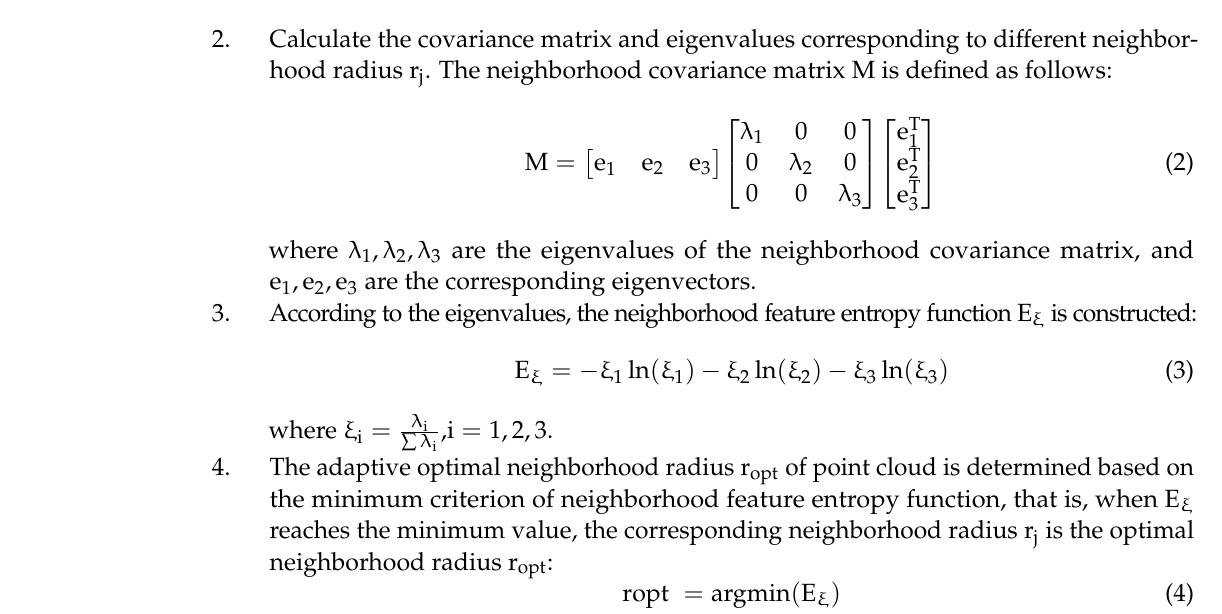
Figure 4. A neighborhood point diagram of a key point. Therefore, an improved FPFH is proposed; each key point q k in the key point set Q t is taken as the query point, and based on the adaptive optimal neighborhood radius r opt , all the neighborhood points q ki within its neighborhood radius are found. The weight co- efficient is redefined with the Gaussian distribution, as follows: 2 i Gi